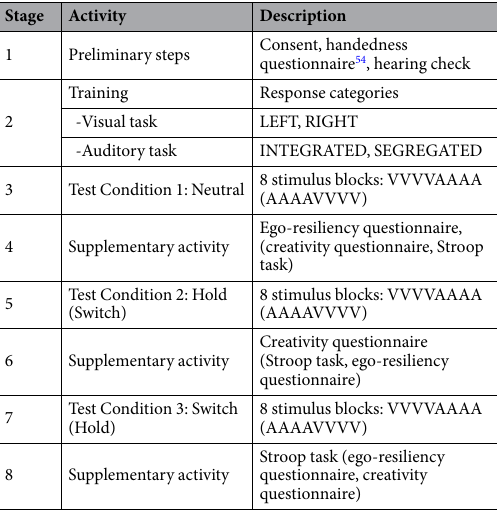
Table 2. Experimental design, showing the eight stages in an experimental session. The order of the following was counterbalanced across participants: a) modality ordering of stimulus blocks, VVVVAAAA or AAAAVVVV, b) biased test conditions Hold/Switch in stages 5 and 7, c) supplementary task order ego- resiliency/creativity/Stroop in stages 4, 6 and 8.